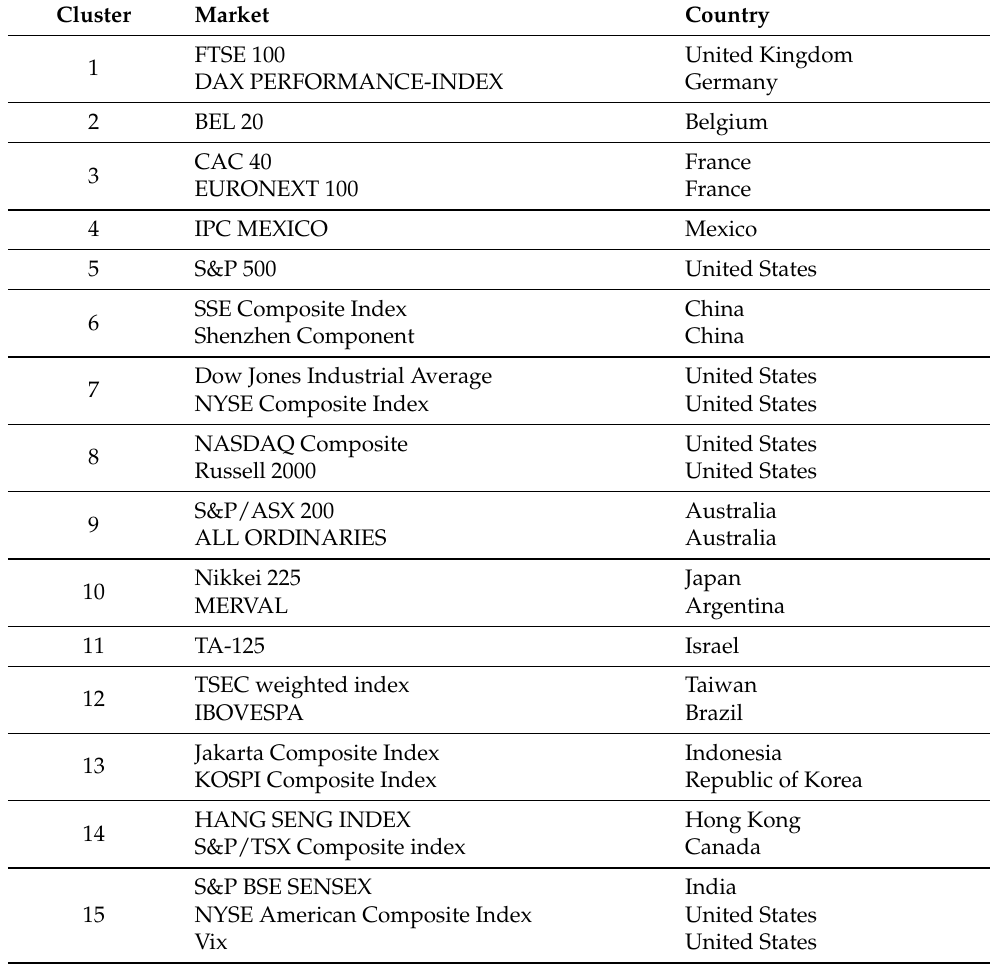
Table 2. The collection of country lists according to the long-term hierarchical clustering of effi- ciency patterns.